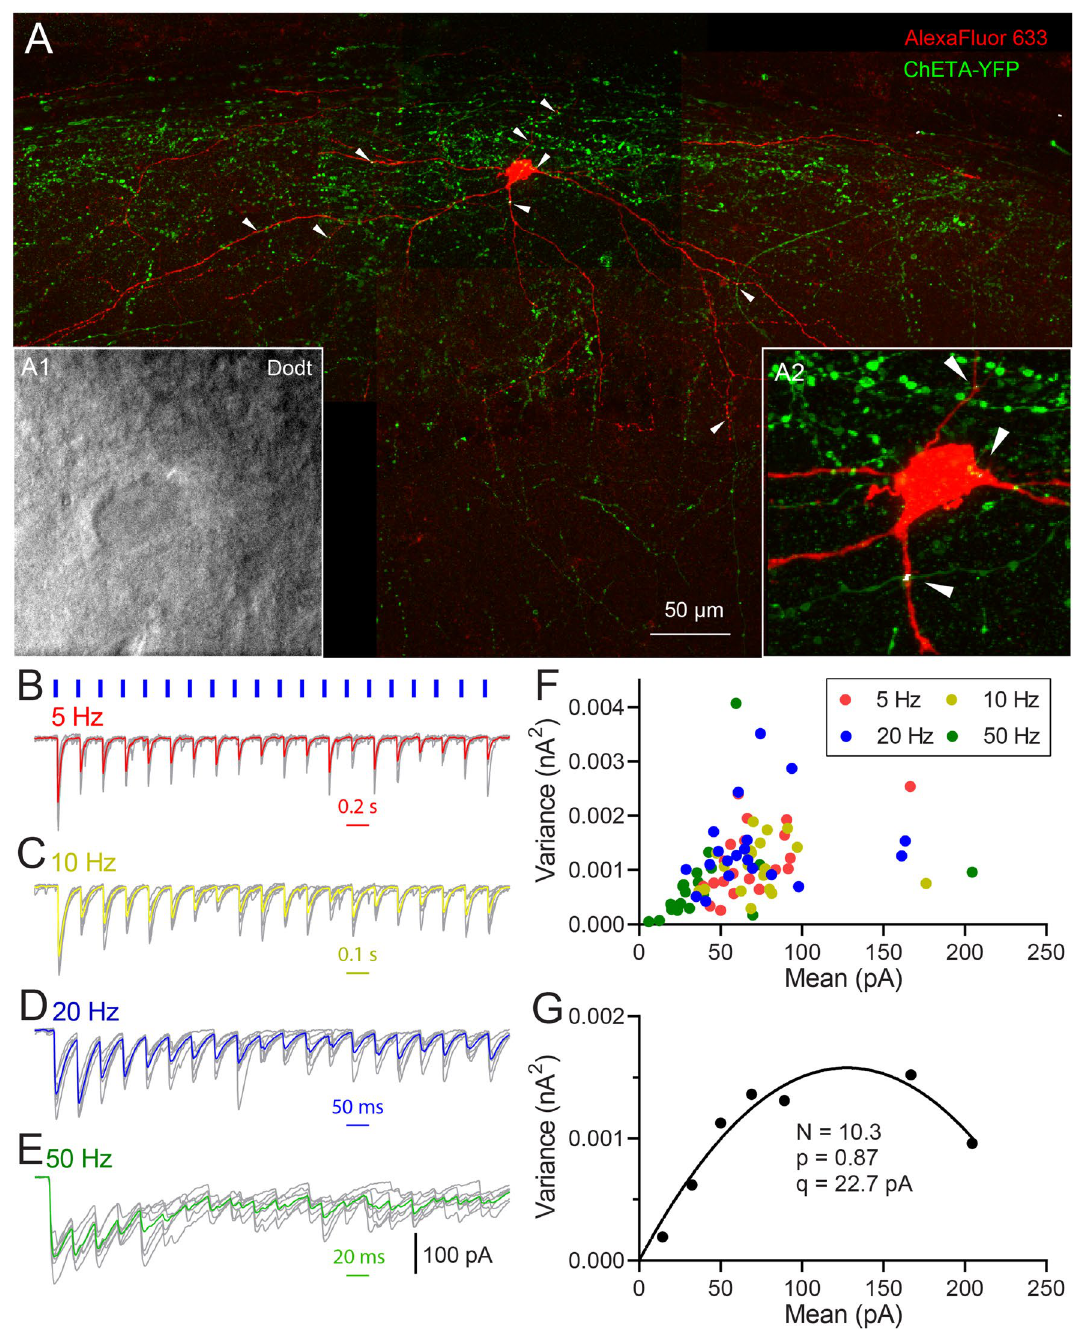
Figure 3. PV MS-DBB transmission onto a representative hippocampal CA1 stratum oriens interneuron. ( A ) Post-hoc recovery of a biocytin filled cell. Co-localization points of potential actual contact (red/greed overlap depicted in white) of ChETA-YFP axons (green) and biocytin-filled cell (red) are indicated by white arrows. ( A1 , inset) Live IR Dodt contrast of the recorded CA1 SO cell. ( A2 ) magnified image of the cell body. ( B – E ) 5, 10, 20 and 50 Hz (20 pulses of 1 ms duration, depicted as blue short lines) 470 nm light pulse trains evoked IPSCs (raw traces,grey; average trace, colored). Each train was repeated 7 times. ( F ) The peak variance (V) and mean (M) was computed for each pulse in each train in ( B – E ). In ( F ), 20 VM points are shown for (red) 5 Hz, (yellow) 10 Hz, (blue) 20 Hz and (green) 50 Hz conditions, with each point representing the M and V of 7 individual IPSCs. VM points in F are binned in 20 pA increments ( G ). Assuming an intrasite quantal variance of 0.3 42 , the V–M relationship was fit by the parabolic function δ 2 = ( 1 + CV 2 ) qI − I 2 / N , where δ 2 is the variance, I is the mean, N is the number of functional release sites, CV is the intrasite coefficient of variation, and q is the quantal